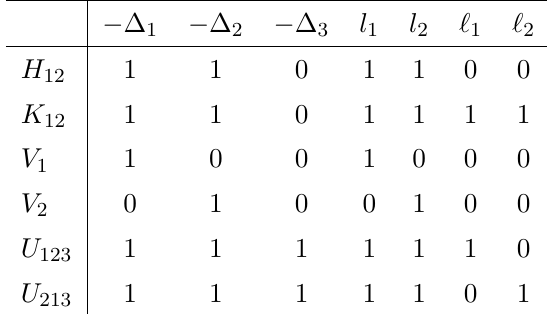
Table 1. Degrees of tensor structures of the MST 2 -MST 2 -scalar 3-point function in d > 4 .